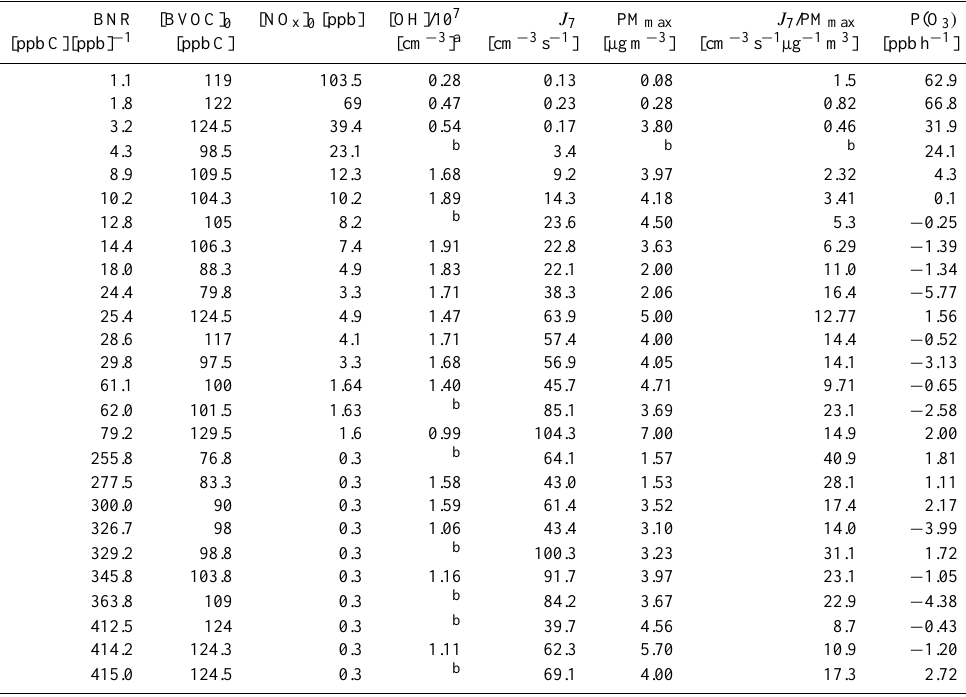
Table 1. Results from experiments with respect to particle formation from OH initiated oxidation of BVOC emitted from Mediterranean tree species.